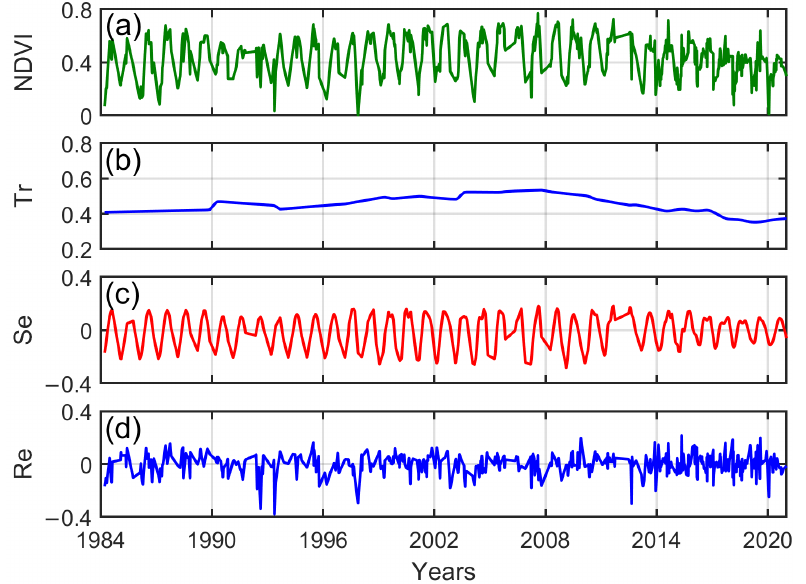
Figure 3. ( a ) NDVI time series at South Kennemerland, the Netherlands and its JUST decomposition in the ( b ) trend Tr, ( c ) seasonal Se and ( d ) remainder Re components. The decomposition shown in ( b – d ) was based on the chosen automated settings (see text), that is, a window size M = 90; a window translation step δ = 34; thresholds for the magnitude mag _ th and direction dir _ th of the jumps of 0.2; and the minimum time difference between jumps jump _ th = 2 years. No jumps were detected in this NDVI time